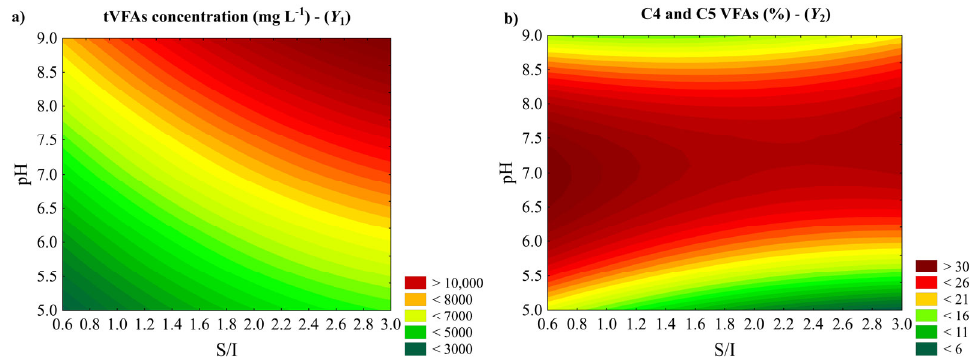
Figure 1. Fitted response surfaces generated from quadratic models for ( a ) total VFAs (formic, acetic, propionic, isobutyric, butyric, valeric, and isovaleric acids) concentration ( Y 1 , mg L − 1 ) and ( b ) amount of C4 and C5 VFAs ( Y 2 , %) .